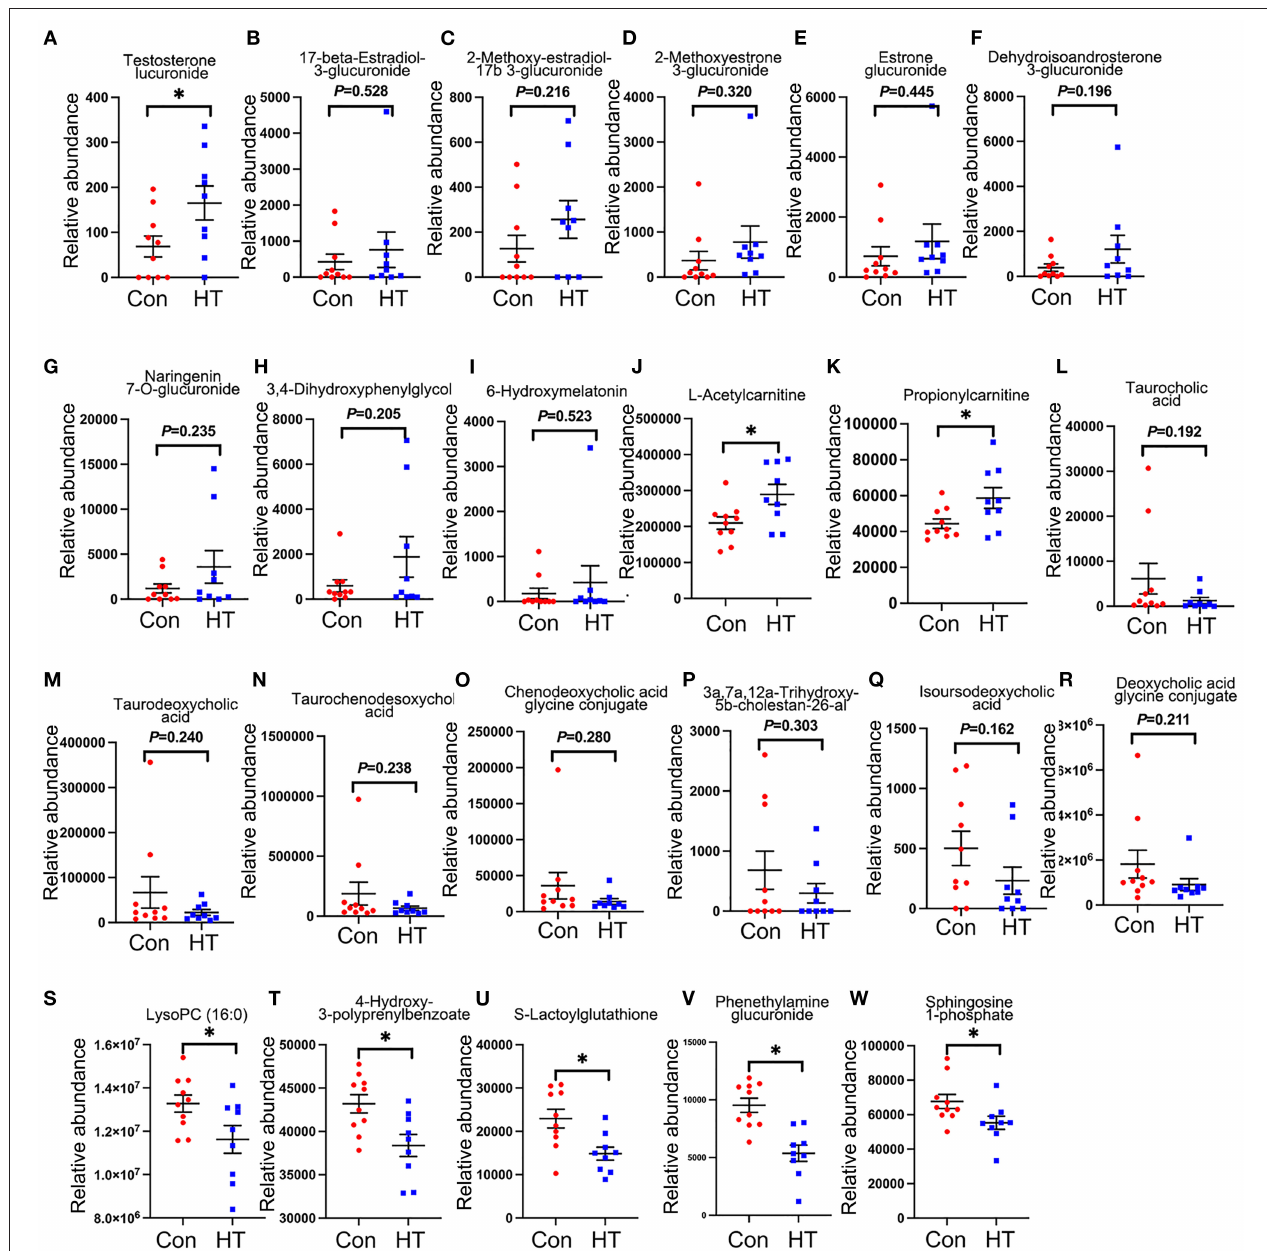
FIGURE 4 | HT-induced alterations in plasma metabolites. (A–W) The relative quantification of plasma metabolites. Data were expressed as the mean ± SEM. * P < 0.05.